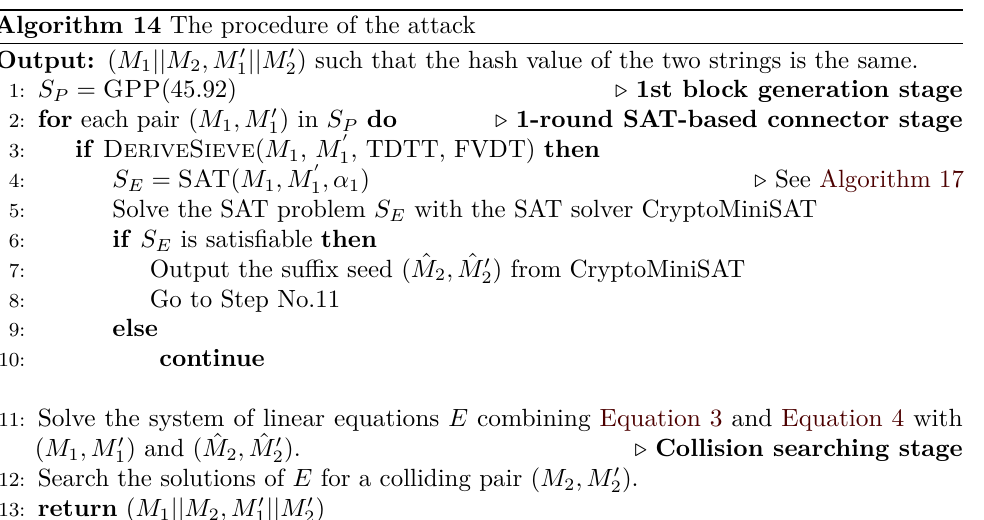
Algorithm 14 The procedure of the attack